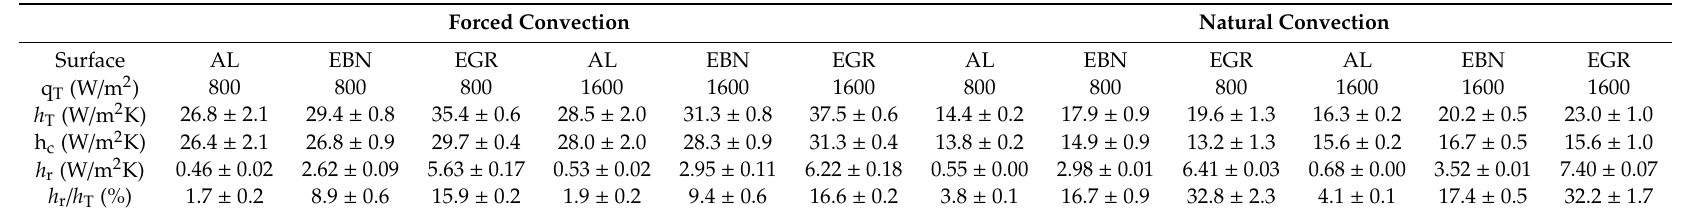
Table 9. Comparison of heat transfer coe ffi cients in forced and natural